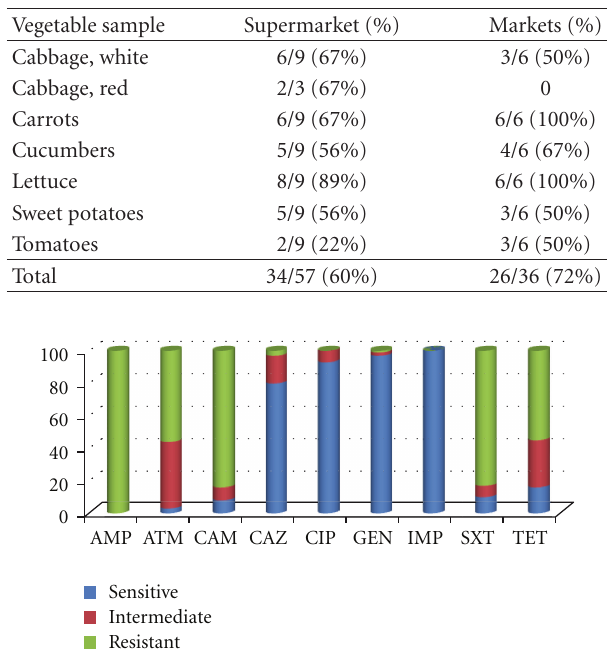
Figure 1: Frequency of resistance among P. aeruginosa iso- lates to common several antimicrobial agents. AMP: ampicillin; ATM: aztreonam; CAM: chloramphenicol; CAZ: ceftazidime; CIP: prim/sulfamethoxazole; TET: tetracycline.